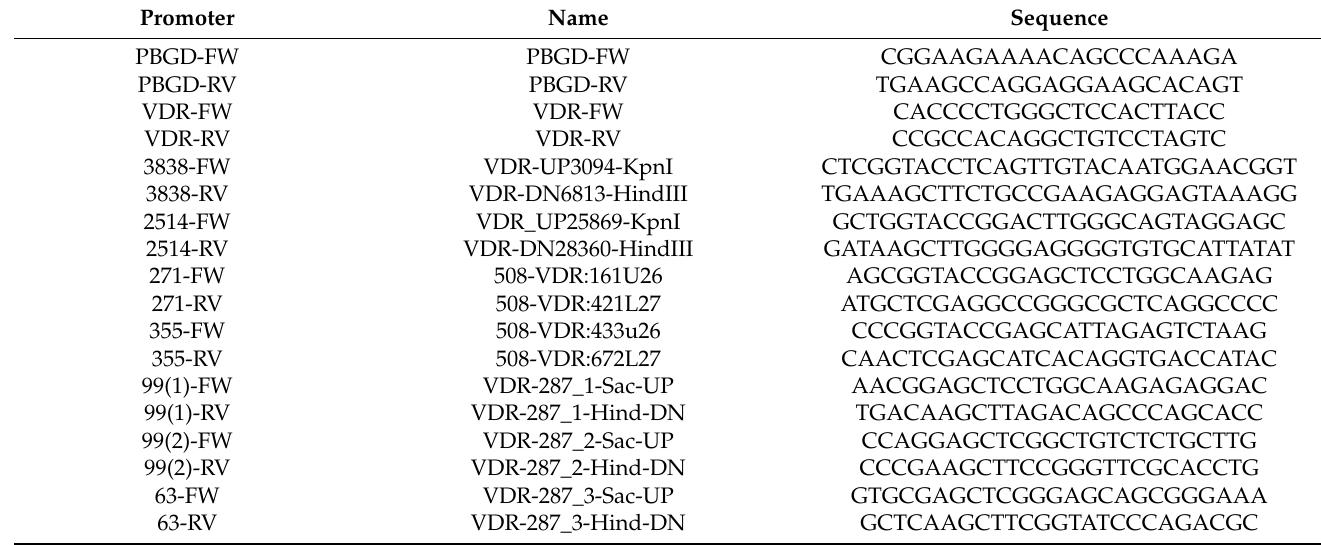
Table 1. List of primers used in the present work. FW (forward), RV